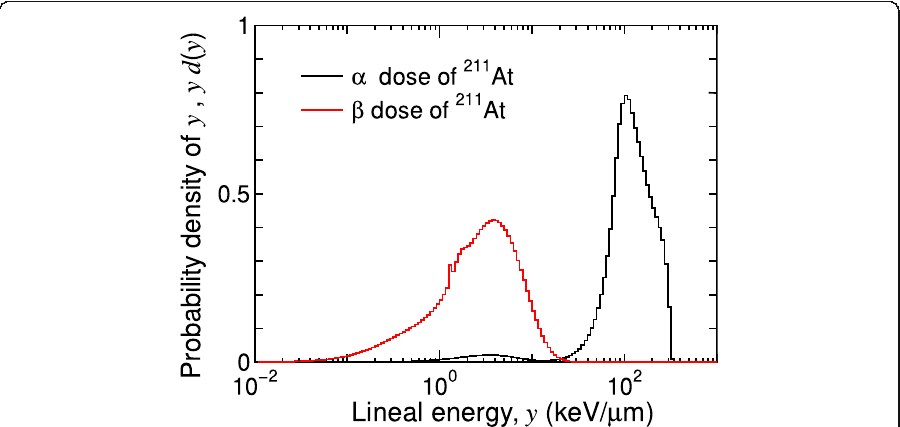
Fig. 2 Calculated dose PD of y , yd ( y ), for r d = 0.282 μ m for the α and β doses of 211